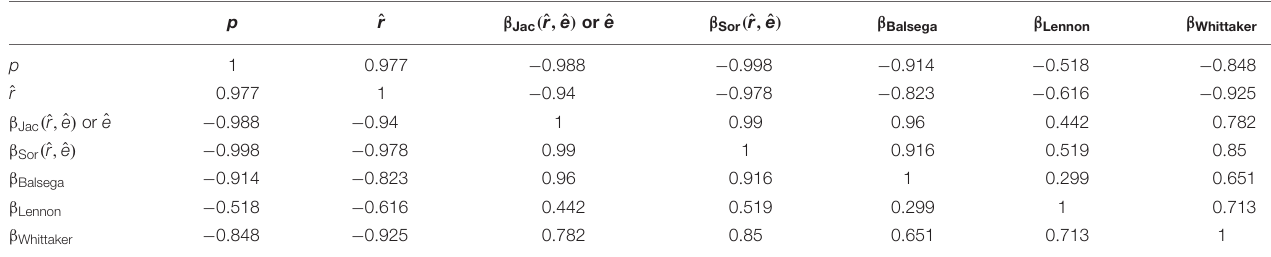
TABLE 2 | Relationships (measured by the correlation coefficient) of the colonization rate, extinction rate, and the multi-site beta diversity estimated using the proposed likelihood model with other multi-site calculation methods in a numerical simulation when the matrix filling degree ( p ) varies. p ˆ r β Jac ( ˆ r , ˆ e ) or ˆ